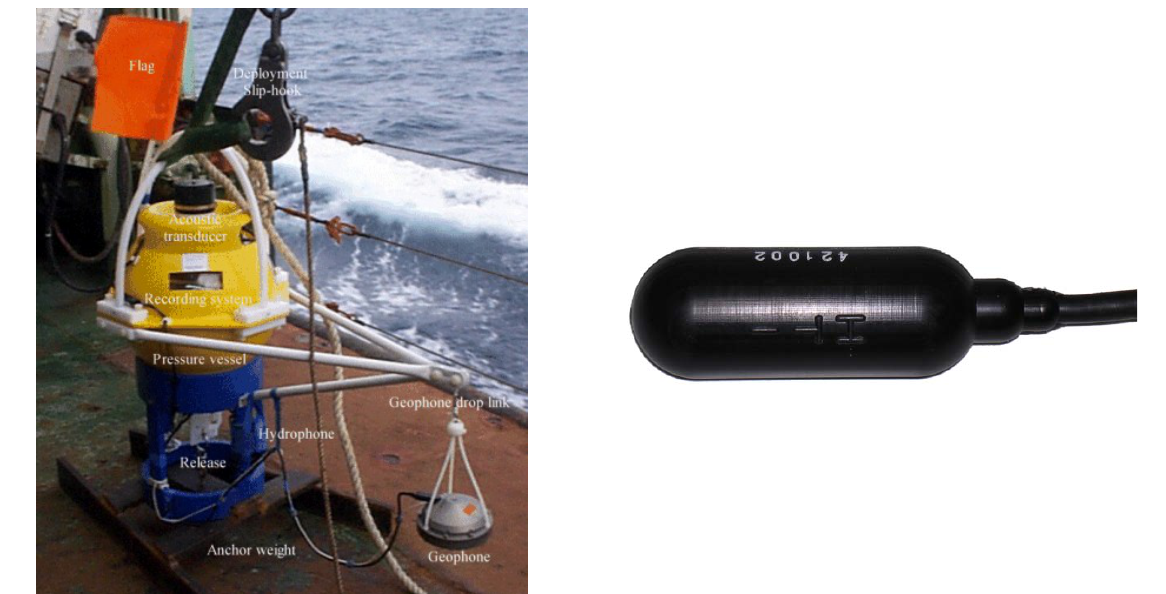
Figure 6. Different parts of the OBS preliminary design using glass sphere. Hydrophone detail from Hytech